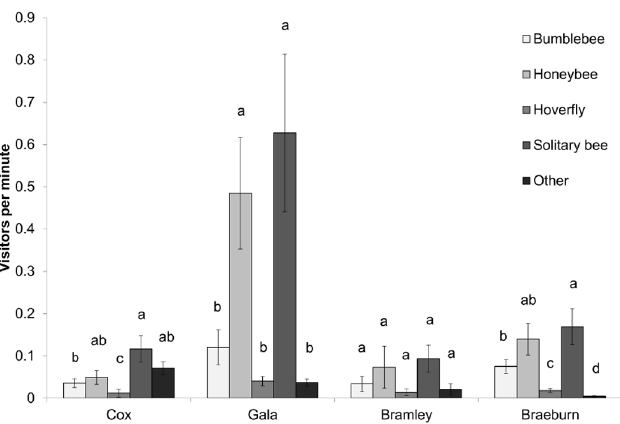
Fig 2. Number of visits observed to different apple variety flowers by different pollinator taxa. Mean ± SE visits per minute per survey shown. Within variety, bars with different letter are significantly different (P < 0.05) following analysis of raw count data using generalised linear mixed effects models.